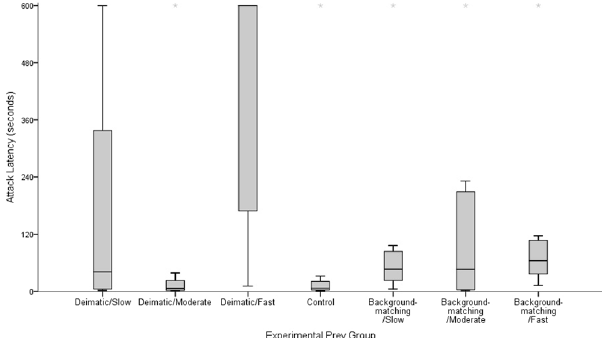
Figure 1. Latency to attack prey during the test trial. Each box represents the middle 50% of scores for each experimental group. The line dividing each box into two represent the median of those data. The upper and lower whiskers extend to include the data outside the middle 50%. Asterisks ( * ) represent possible outliers, each of which has been examined and is valid for inclusion within the